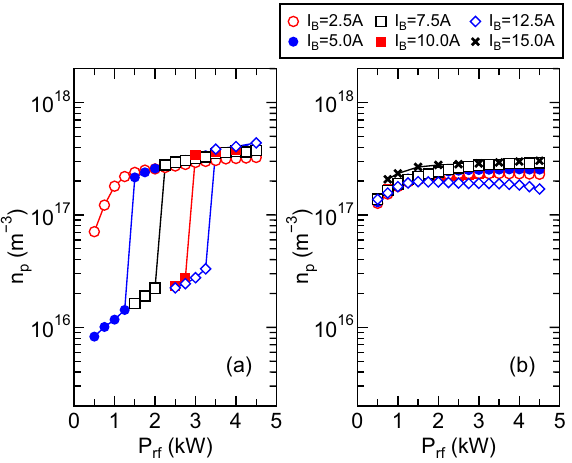
0 (open source exit) for various values of the solenoid Figure 4. Plasma density measured on the z axis at z = 0 mode antennas. Typical error 1 and ( b ) m current I B as a function of the rf power P rf for the ( a ) m = = + 5% . The discontinuous change in the density is seen for the m 1 case bar in the measurement is about ± = + simultaneously with the transition in the power transfer efficiency (see Fig. 3a), while no discontinuous change 0 mode case. is detected for the m =